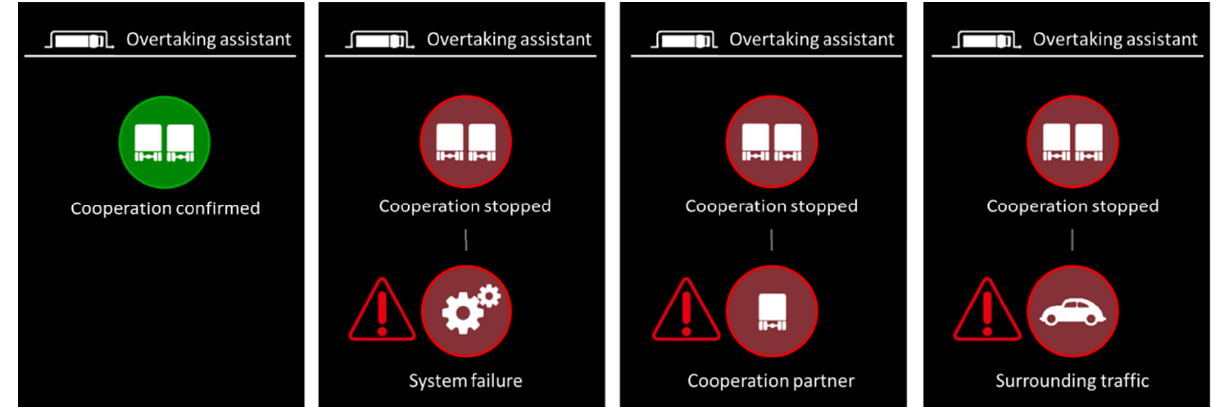
Figure 2. Symbols of the three different systems with explanation text.